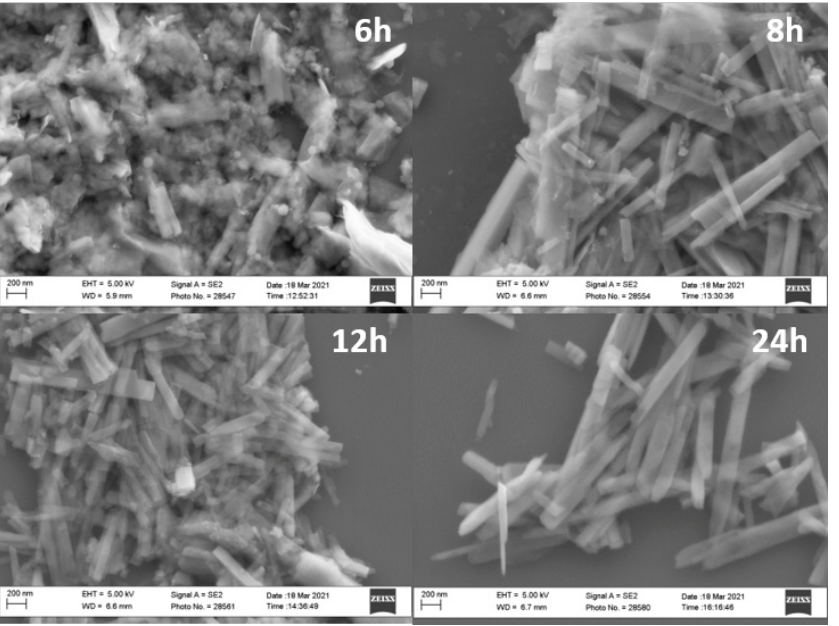
Figure 2. SEM measurements of the following samples: V4 1.7 _6h, V5 1.7 _8h, V6 1.7 _12h, V7 1.7 _24h, labeled as 6 h, 8 h, 12 h, and 24 h respectively.